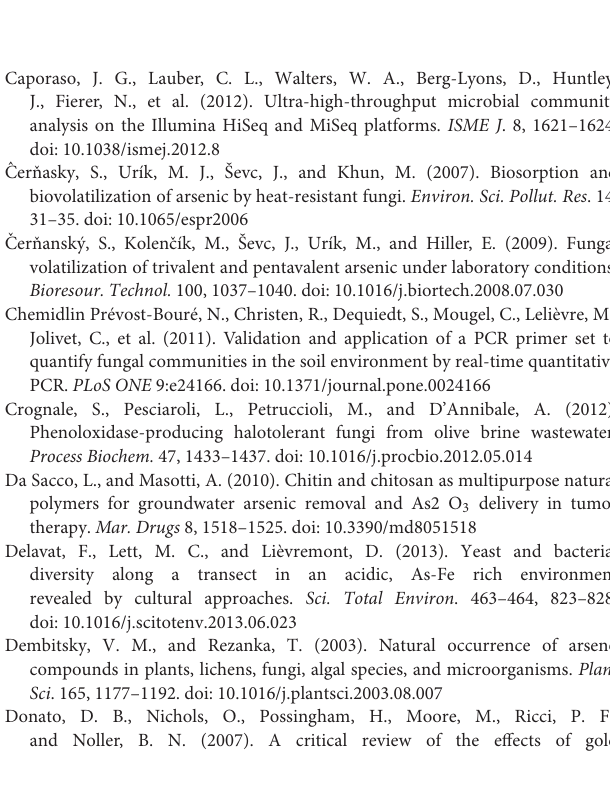
Figure S1 | Satellite view, density tree, altitude, and annual meteorological data of the sampling site. Gold mine processing area is evidenced by white dashed line. Figure S2 | Rarefaction curves of observed OTUs within the 16S rRNA sequences derived from Pestarena Low As (dotted line), Medium As (dashed line), High As (solid line) soils. Figure S3 | Fungal morphotypes isolated from Pestarena soils. Figure S4 | Morphological changes in (A) T. virens HAS_Q and (B) M. moelleri LAS_E grown on Rose Bengal Agar medium added with 1,000 and 250mg L − 1 of pentavalent As, respectively, in the form of sodium